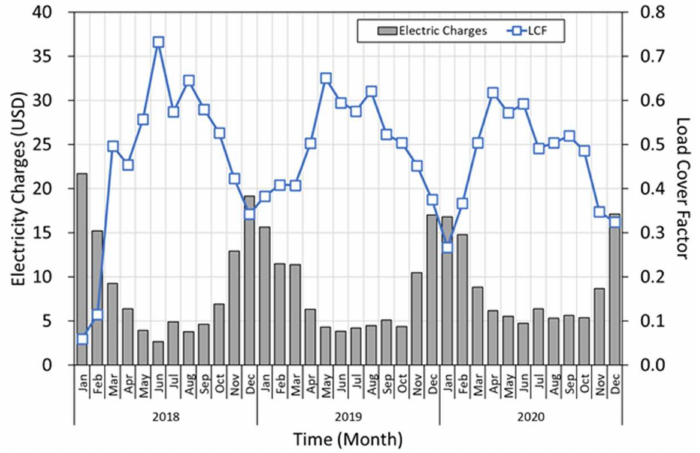
Figure 11. Monthly electricity charges and load cover factor of Gongam house.